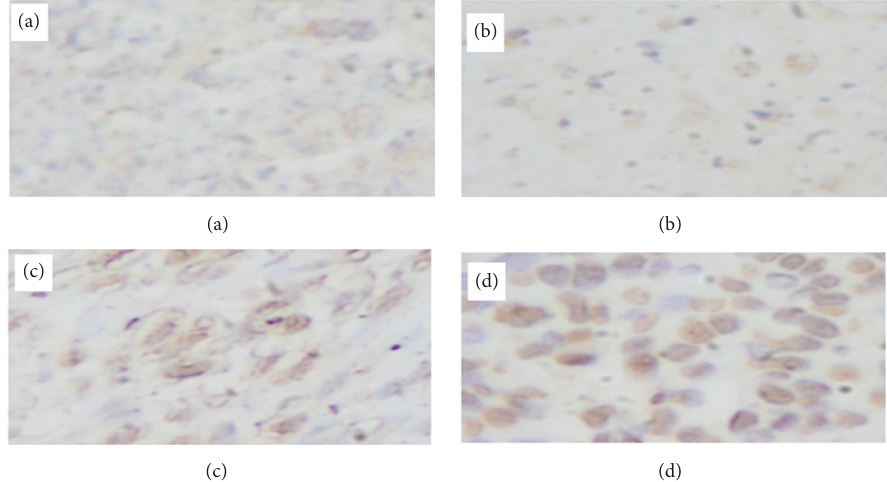
Figure 11: Findings of apoptosis occurring in SCC-7 of C3H mouse after electrochemical therapy. ApopTag (cid:2) Harris hematoxylin stain. (a) Control group, scattered with few apoptotic cells (x200). (b) 10mA × 150sec group with mild degree of apoptosis 6 hours after electrochemical therapy (x400). (c) 10mA × 300sec group with moderate degree in apoptosis 6 hours after electrochemical therapy (x400). (d) 10mA × 600sec group showing marked apoptosis 6 hours after electrochemical therapy (x400). The distribution of apoptosis of the tumor. Quantitation was performed as described in the text and the distribution of apoptotic bodies expressed in relation to position on the tumor cells.